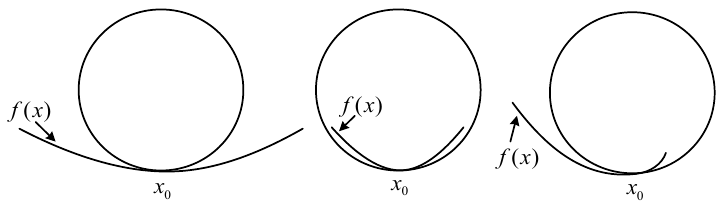
Figure 10. The position relations between a circle of curvature and the curve.